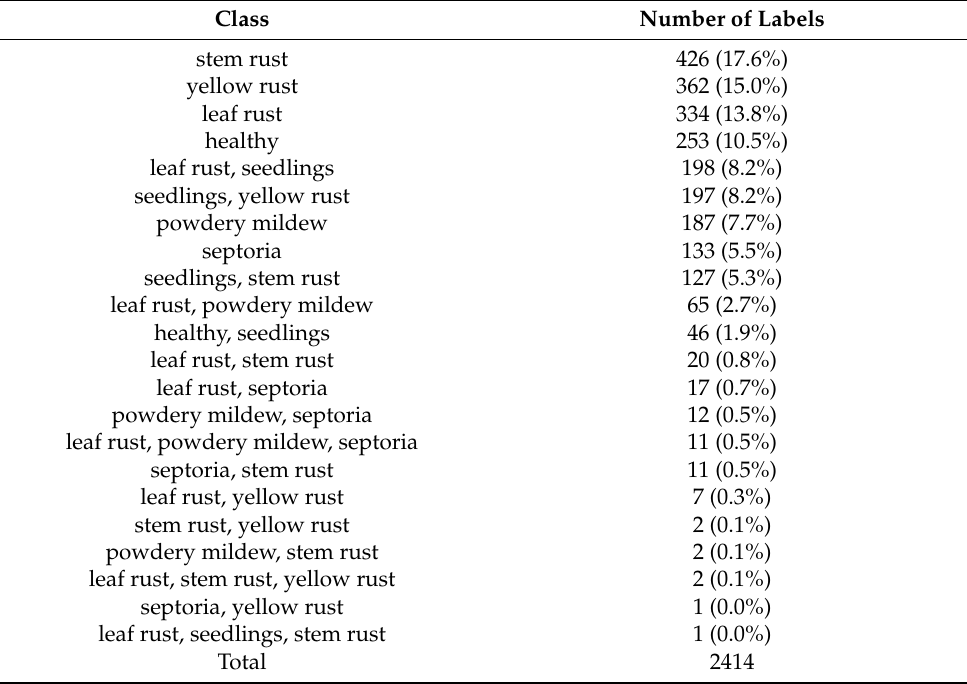
Table 4. The number of images with different combinations of labels in the WFD2020